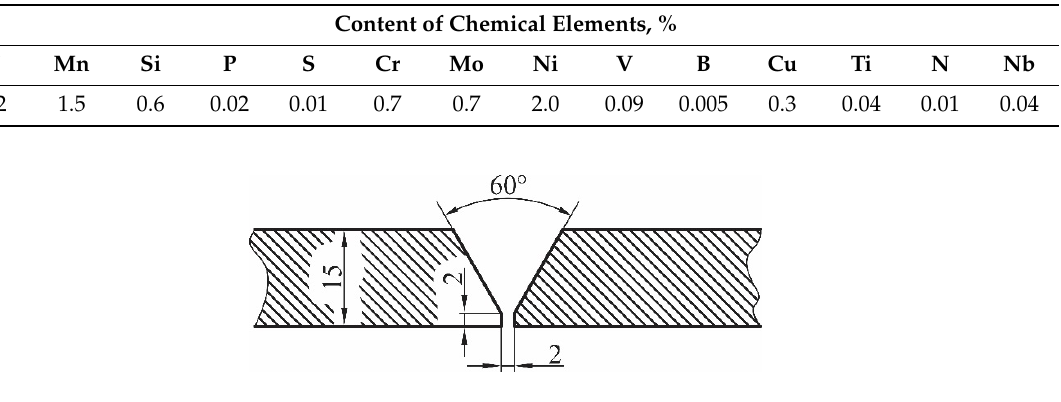
Figure 1. Shape and dimensions of the single V groove. Table 2. Welding parameters and related consumables